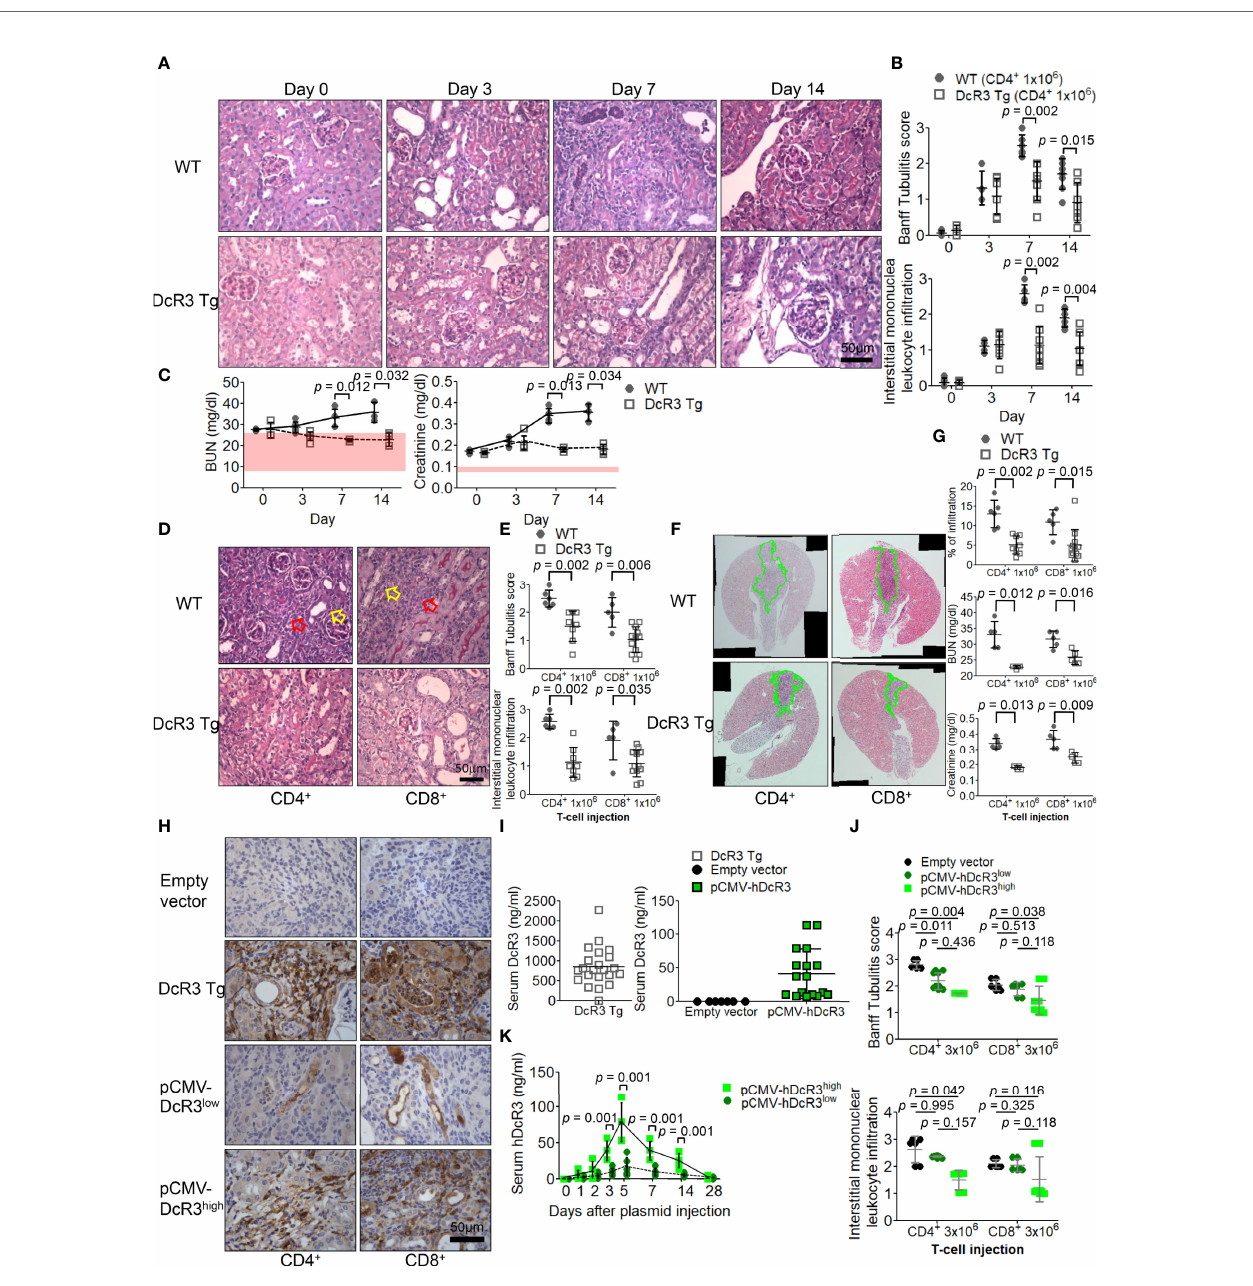
FIGURE 1 | Decoy receptor 3 (DcR3) ameliorated renal dysfunction in the acute cell rejection model. (A) Representative periodic acid – Schiff staining of wild-type (WT; upper panel) and DcR3 transgenic (Tg; lower panel) mice kidneys (×400). (B) Banff tubulitis (t) and interstitial in fl ammation (i) scores. (C) Serum blood urea nitrogen (BUN) and creatinine levels were measured at days 0, 3, 7, and 14 post-injection (5 mice per group; the normal ranges of serum BUN and creatinine levels are indicated by the light pink rectangles). (D) Histopathology of WT and DcR3 Tg mice at day 7 after 1 × 10 6 CD4 + and CD8 + T-cell injection (hollow yellowish and red arrows highlight tubulitis and interstitial mononuclear leukocyte in fi ltration, respectively; ×400). (E) Banff t and i scores at day 7 after 1 × 10 6 CD4 + and CD8 + T- cell injection. (F) In fi ltrated area from two sagittal sections of each kidney stained with hematoxylin and eosin at day 7. (G) Percentage of in fi ltrated area, serum BUN, and creatinine of WT and DcR3 Tg mice at day 7 after 1 × 10 6 CD4 + and CD8 + T-cell injection. (H) DcR3 immunohistochemical staining of plasmid tail vein injection mice in kidney rejection model (×400). (I) Serum DcR3 levels in Tg, empty vector, and pCMV-hDcR3-delivered WT mice. (J) Banff t and i scores in mice treated with empty vector and human DcR3 plasmid at day 7 after 3 × 10 6 CD4 + and CD8 + T-cell injection. (K) WT mice transferred hDcR3 plasmid with high expression (pCMV- hDcR3 high ) or low expression (pCMV-hDcR3 low ) of DcR3 phenotype to regulate the disease. Both the high and low DcR3 expressions were de fi ned by median DcR3 protein levels in the serum. (J) The results of multiple groups were analyzed using Kruskal – Wallis test, followed by Bonferroni post-hoc analysis, and those data were presented as mean ±